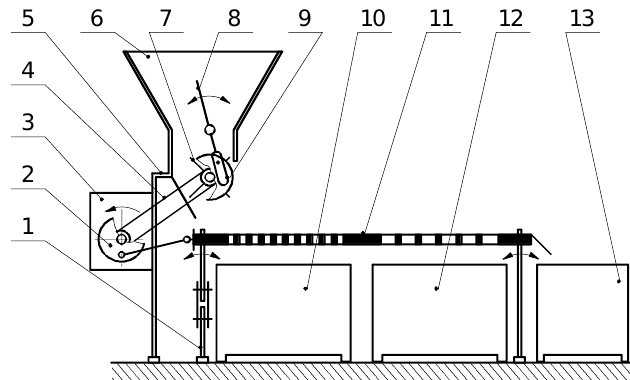
Figure 2. Schematic diagram of the designed calibrator for cauliflower and broccoli florets: 1 — control arm with adjustable length, 2 — mechanism driving the screen box, 3 — electric motor, 4 — belt transmission, 5 — load-bearing frame, 6 — hopper, 7 — feeder, 8 — stirring rod, 9 — mechanism driving the stirring rod, 10 — container for excessively crushed florets, 11 — screen box, 12 — container for appropriately sized florets, 13 — container for oversized florets.